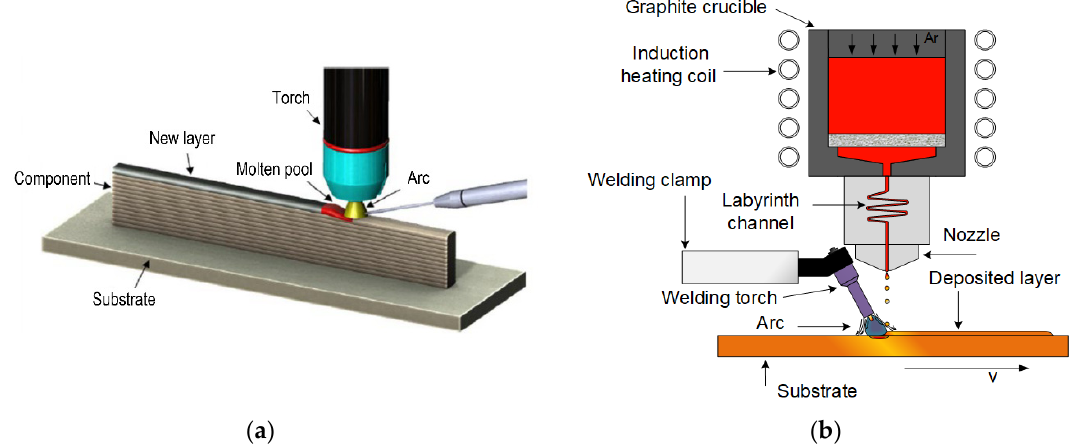
Figure 1. The schematic diagrams of wire and arc additive manufacturing (WAAM) and gas tungsten arc (GTA)-assisted droplet deposition manufacturing (DDM). ( a ) WAAM; ( b ) GTA-assisted DDM.